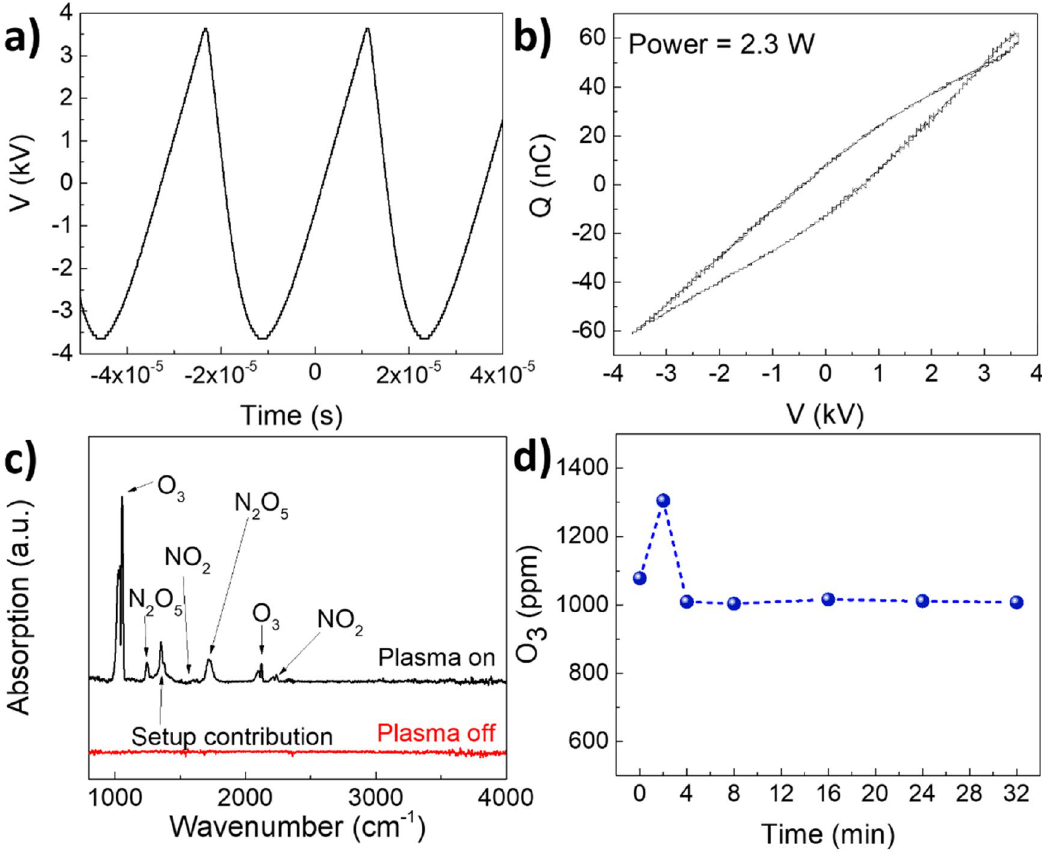
Figure 7. ( a ) Voltage signal produced by the power supply of the plasma globe. ( b ) Lissajous Figure of the plasma globe reactor. ( c ) FTIR analysis of the gas composition produced by the Plasma Globe Reactor and ( d ) corresponding O 3 concentration produced by the plasma globe reactor as a function of time. An average of 1010 ± 5 ppm along the stability period (4 to 32